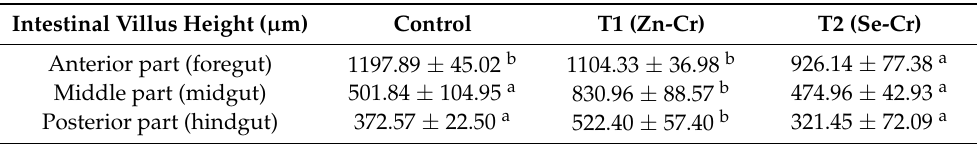
Figure 1. Histology slides of the anterior part ( a ), the middle part ( b ), and the posterior part ( c ) of the intestines of red tilapia that were fed with different organic trace mineral supplementations: control ( C ), T1 ( A ), and T2 ( B ). Table 3. Intestinal villus height of red tilapia that were fed diets with different trace minerals for 8 weeks (mean ± SD).